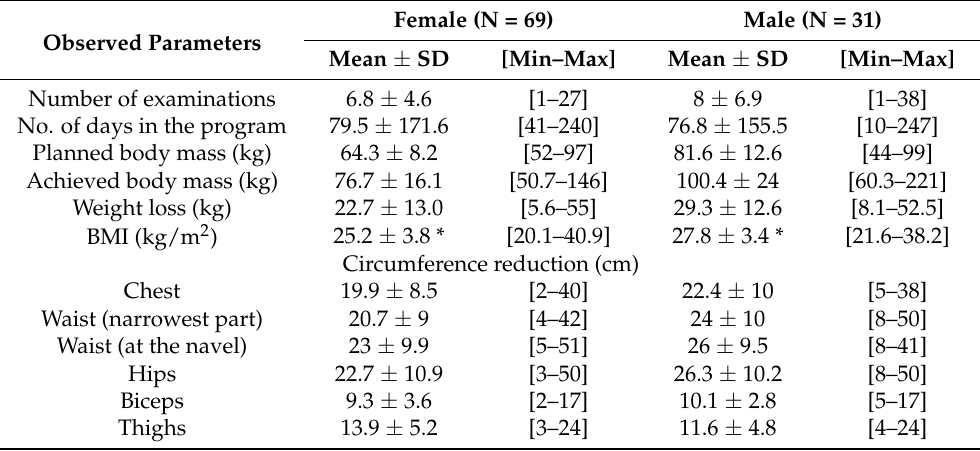
Table 5. Observed parameters on the end of the diet